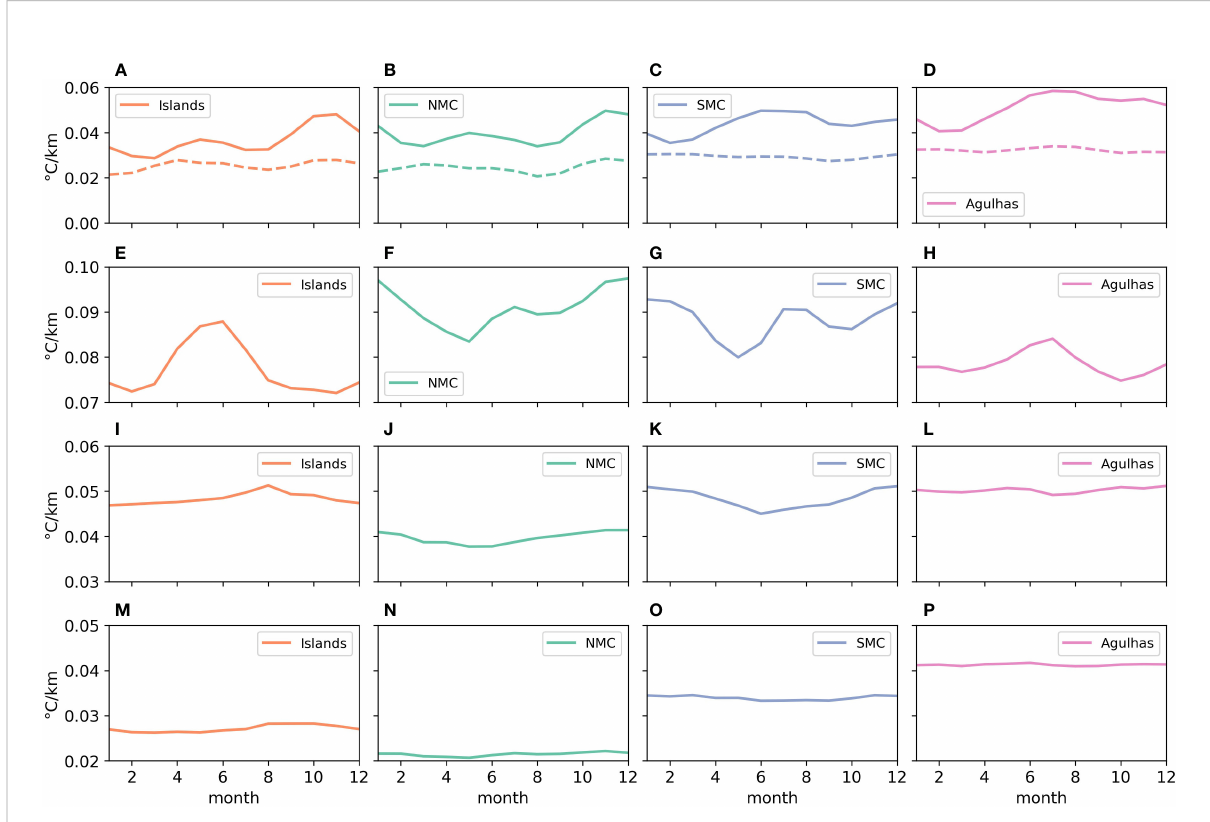
FIGURE 7 Temperature front intensity climatology for each subregion at surface (A-D) , -100 m (E-H) , -500 m (I-L) , -1000 m (M-P) . At surface (A-D) , data from MOZ36 (full line) and from SST MUR (dashed line) are represented. Please note the different y axis